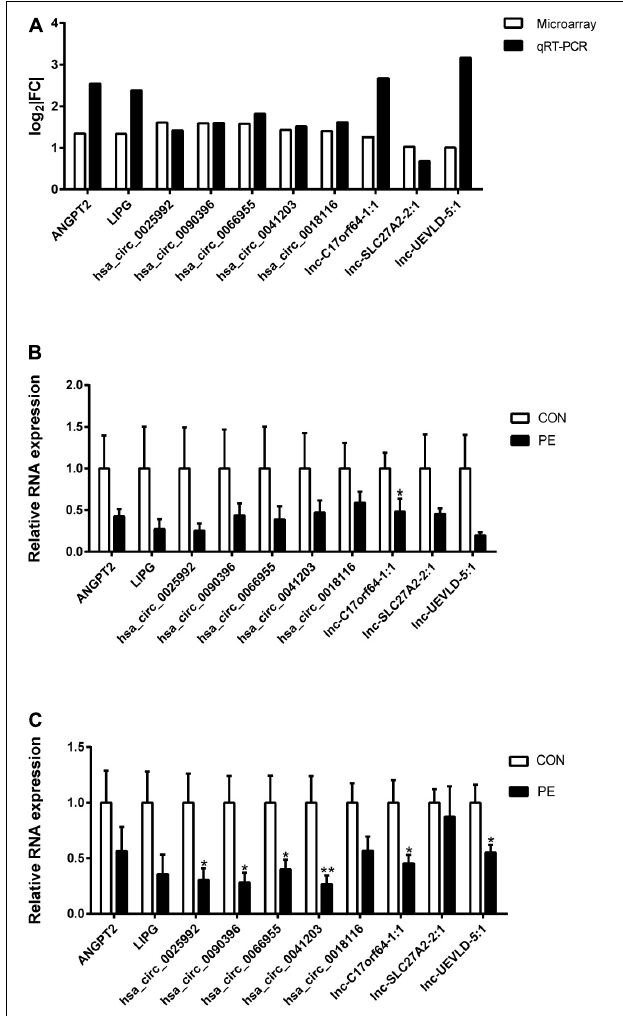
FIGURE 5 | Validation of DERNA expression by qRT-PCR. Differentially expressed mRNAs, circRNAs, and lncRNAs in PE samples by microarray analysis were validated by qRT-PCR (A) , n = 4. Validation of differentially expressed mRNAs, circRNAs, and lncRNAs in 10 pairs of HUVECs (B) and corresponding placental tissues (C) of participants. | FC| = | Fold Change|. CON, control; PE, preeclampsia. Data were shown in mean ± SEM. * P < 0.05; ** P <